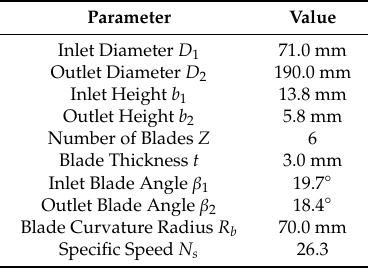
Figure 1. Configuration of the six-blade impeller. Table 1. Geometric specifications of the centrifugal